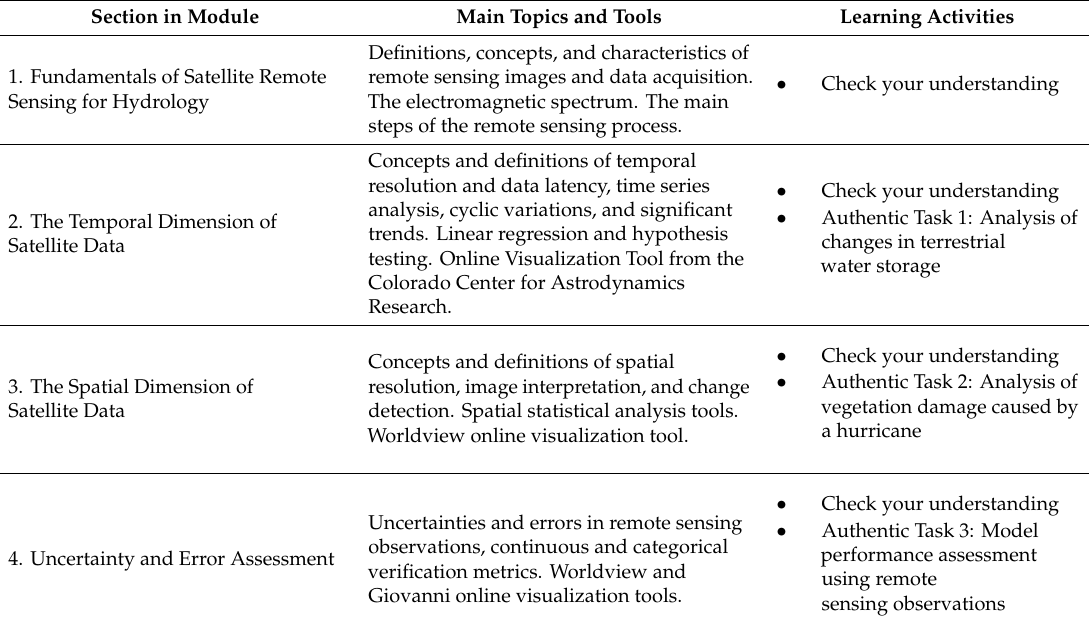
Table 2. Structure of the HydroLearn Remote Sensing Applications in Hydrology module, including the main topics covered and the type of learning activities in each